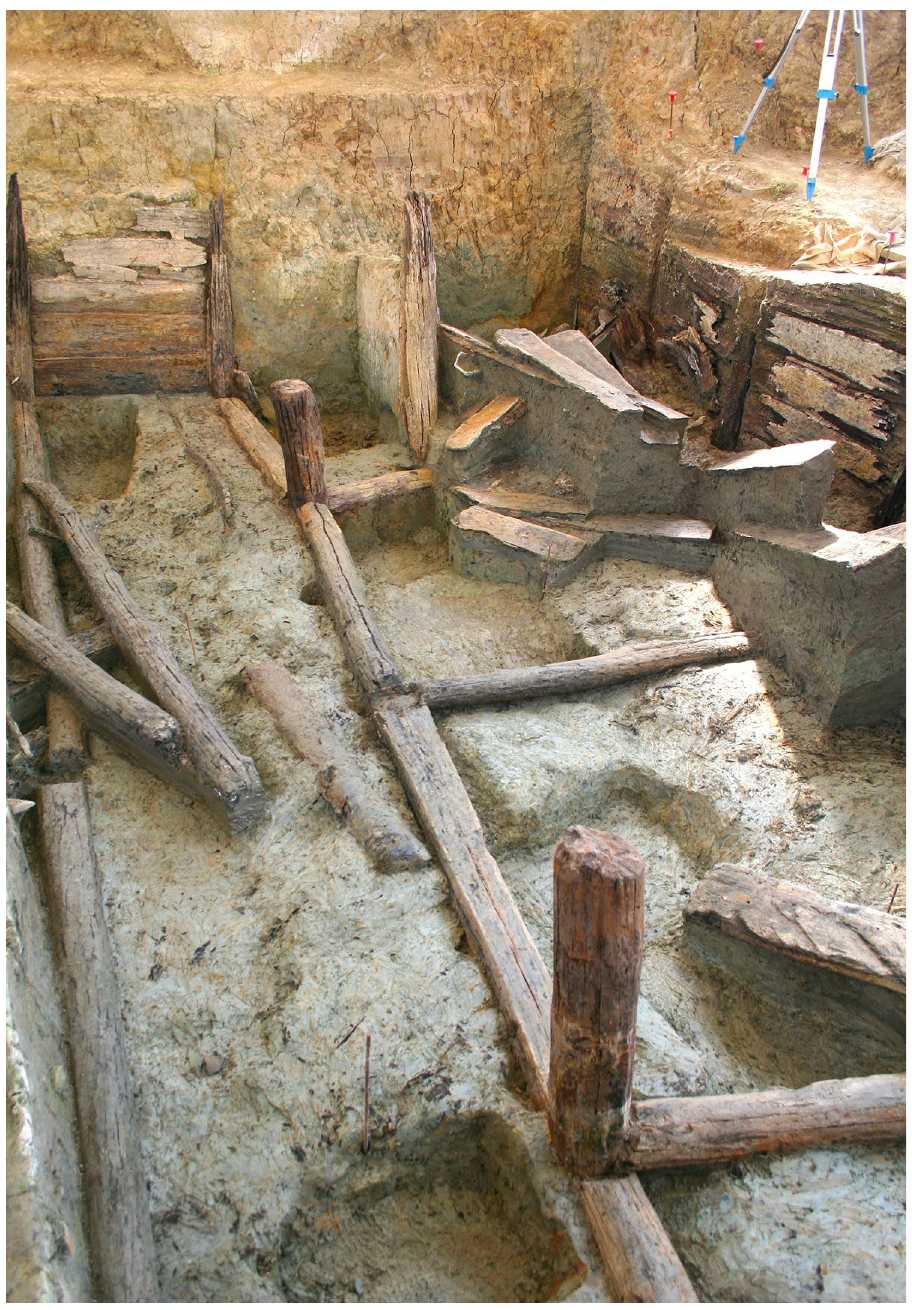
Fig 3. Details of the basal network of beams from the lower tank at